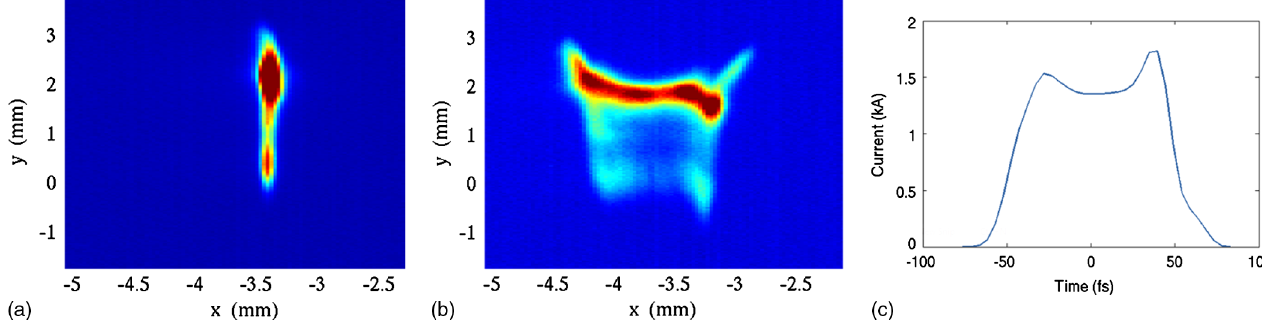
FIG. 12. The measured beam images with deflector (a) off and (b) on at LCLS electron beam energy 13 GeV, bunch charge 150 pC. The curve on (c) shows the current beam profile with absolute units after applying the measured calibration factor.